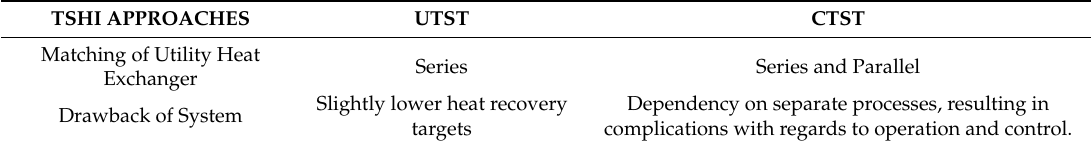
Table 1. Comparison between UTST and CTST methods